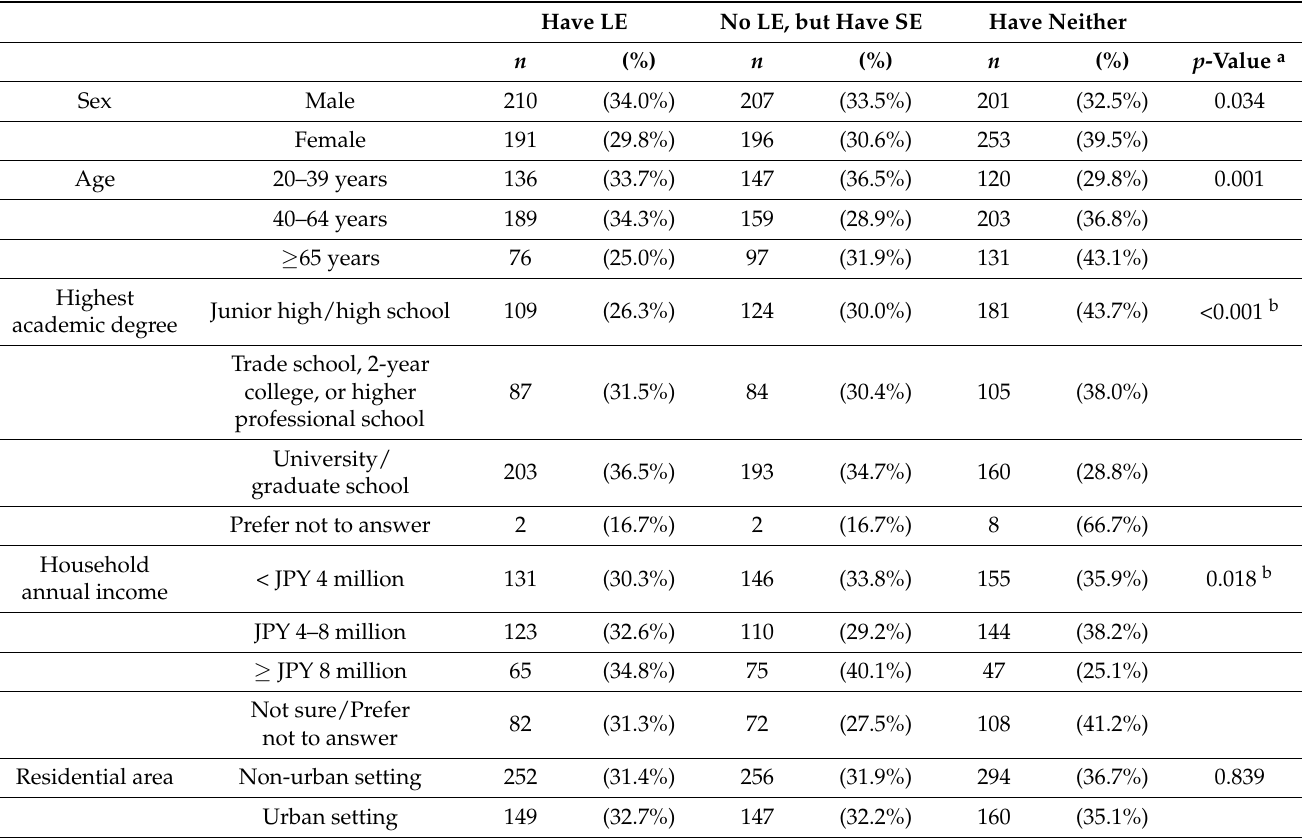
Table 2. Presence or absence of limit experience (LE) or suppression experience (SE) among respon- dents, stratified by basic characteristics.